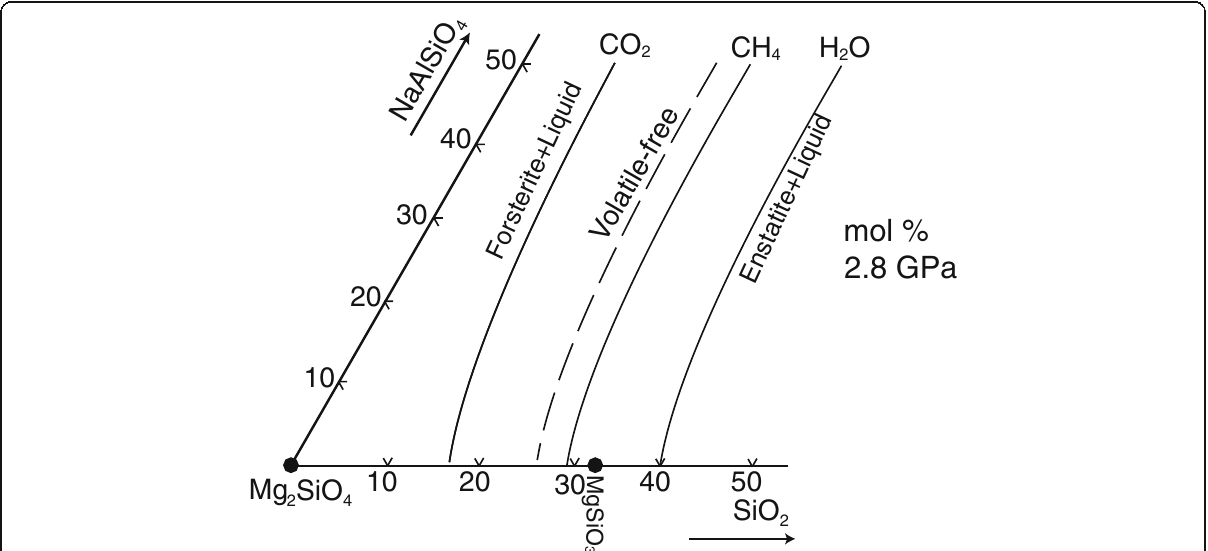
Fig. 1 Simplified liquidus diagram showing the enstatite/forsterite liquidus boundary in portion of the system Mg 2 SiO 4 – NaAlSiO 4 – SiO 2 in the presence of excess CO 2 , CH 4 , and H 2 O. Also shown (with dashed line) is the boundary under volatile-free conditions (data from Taylor and Green